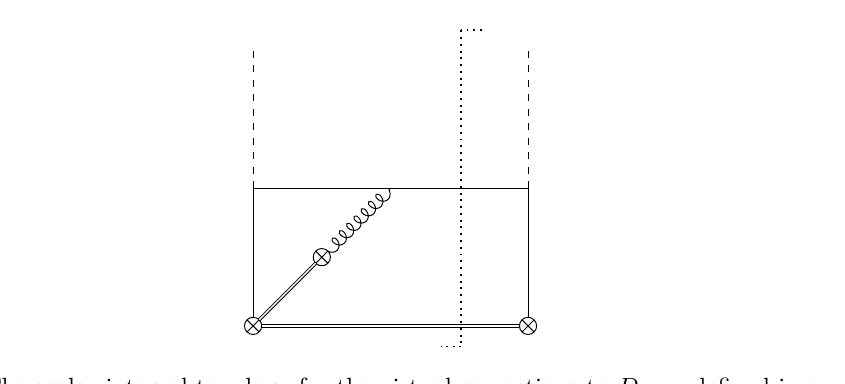
Figure 7. The scalar integral topology for the virtual corrections to D t → H defined in eq. (D.12).